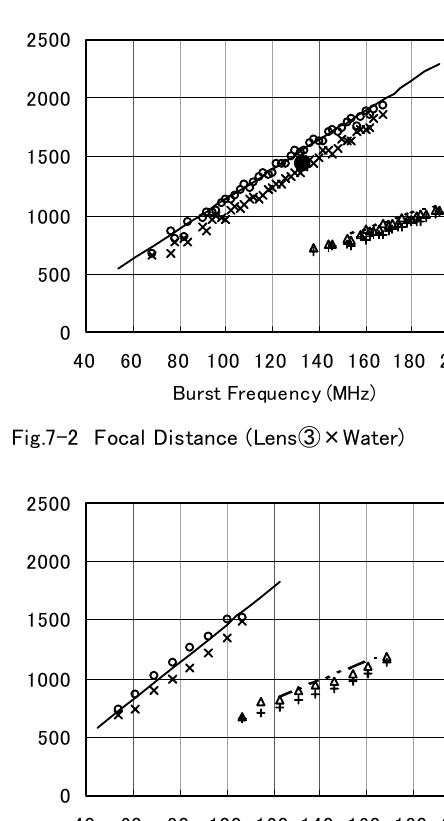
Fig.7-1 Focal Distance (Lens②×Water)